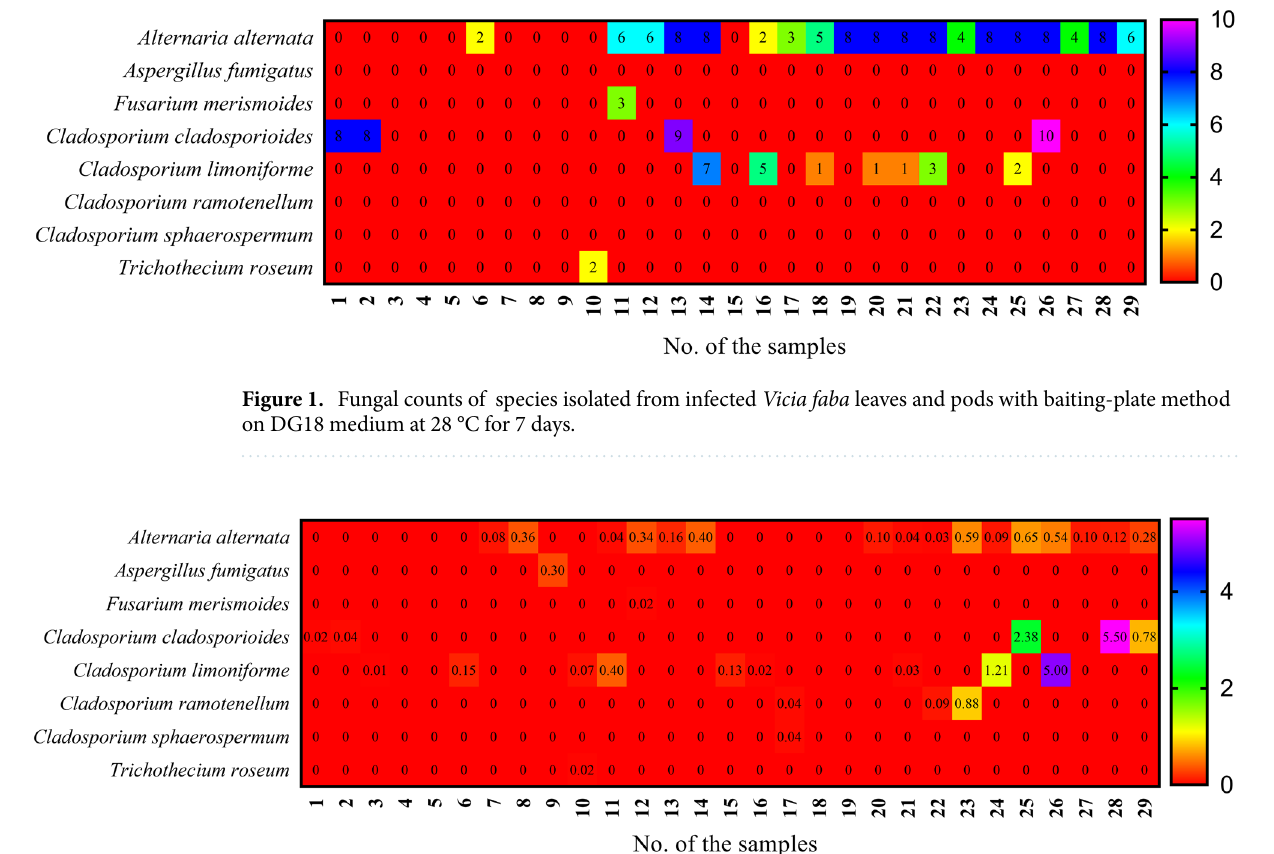
Figure 2. CFU of species isolated from infected Vicia faba leaves and pods with dilution-plate method on DG18 medium at 28 °C for 7